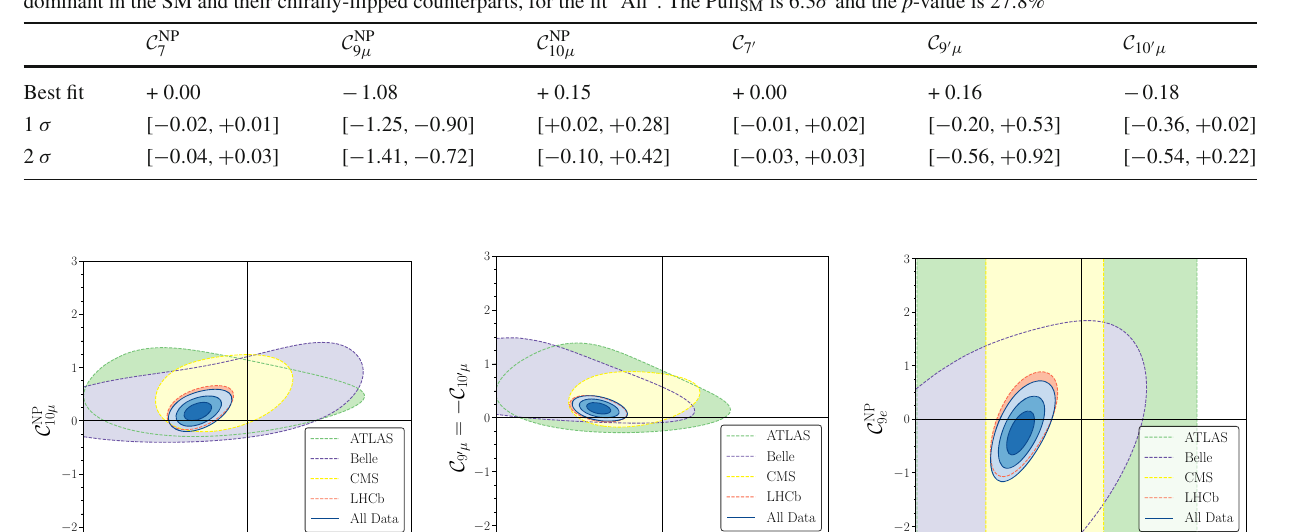
Fig. 1 From left to right: allowed regions in the ( C NP using all available data (fit “All”) upper row or LFUV fit lower row. Dashed lines represent the 3 σ regions while the solid lines represent 1, 2 and 3 σ